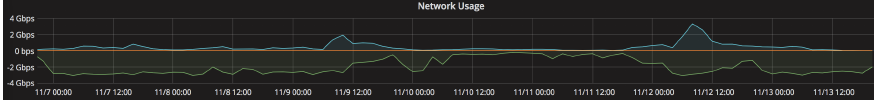
Figure 5: Network Usage over one week for the CMS AAA proxy before changes to the caching. Inflowing data to the proxy is shown as negative and outflowing data as positive. The scale is between -4 Gbps and 4 Gbps.